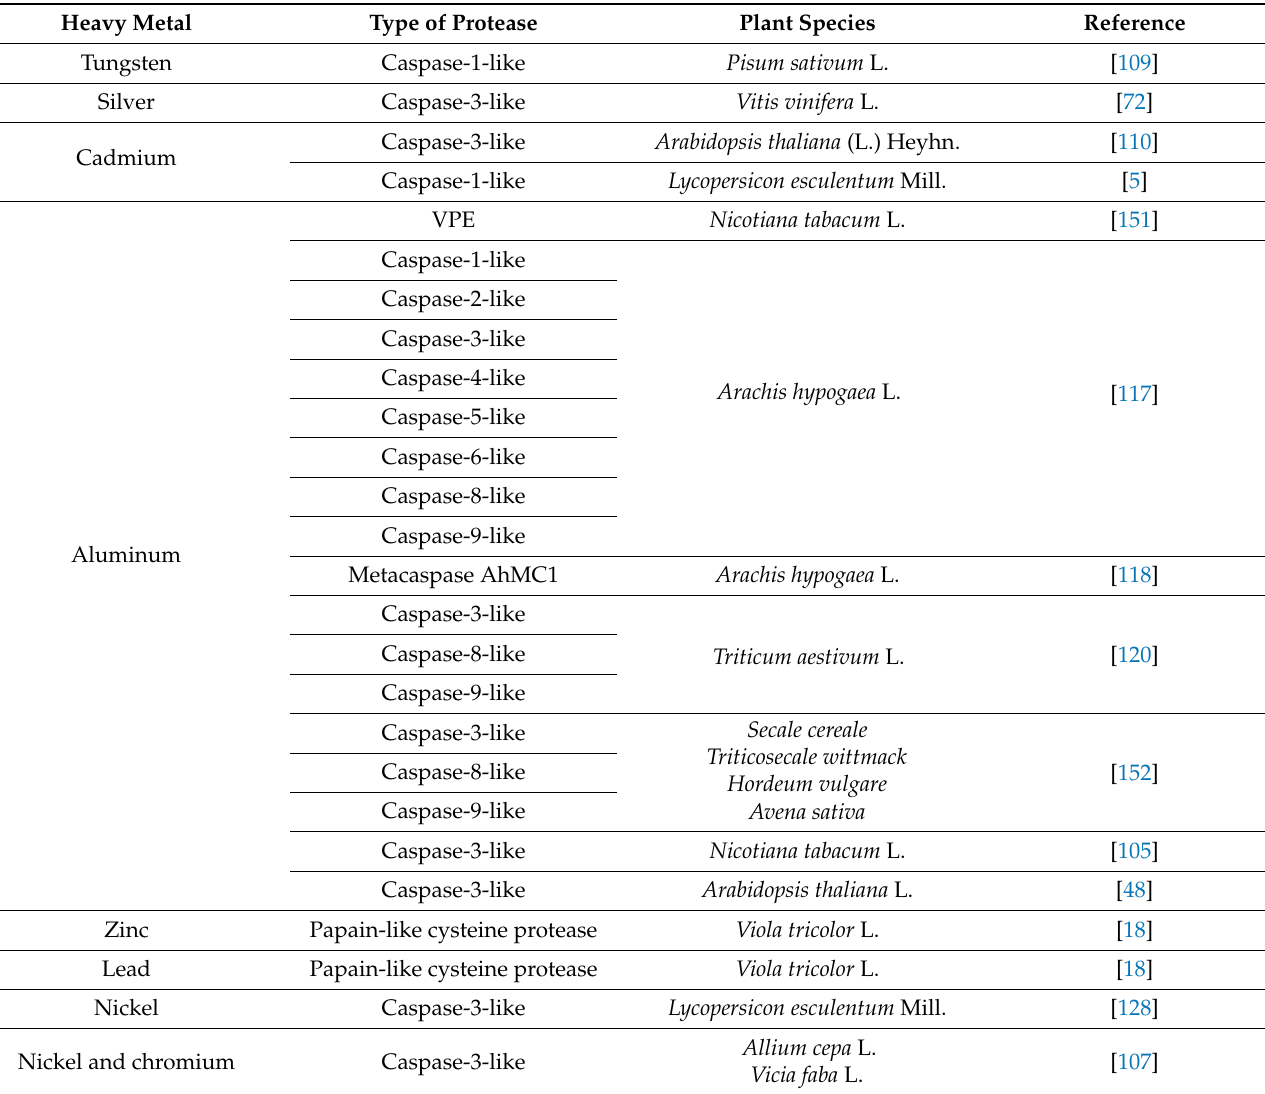
Table 2. The classes of proteases with caspase-like activity involved in programmed cell death (PCD) induced by different heavy metals in different plant